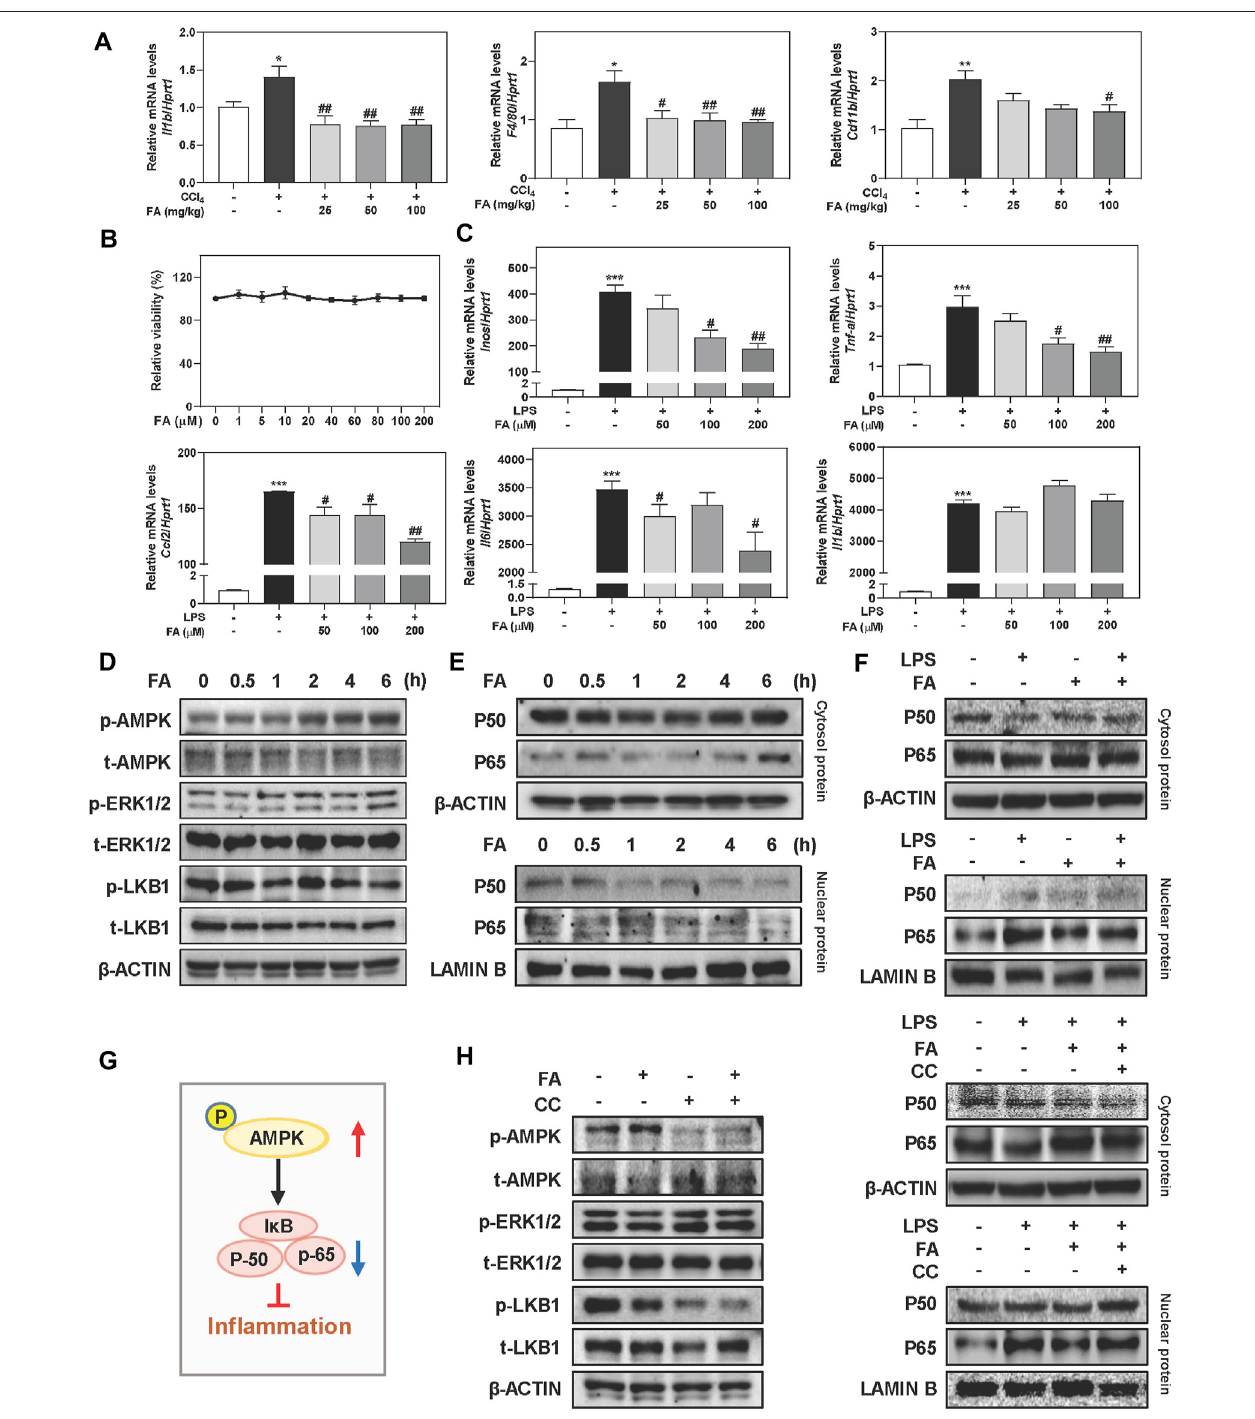
FIGURE 3 | FA suppresses LPS-induced macrophage activation in RAW cells. (A) Relative hepatic mRNA levels of Il1b, F4/80 and Cd11b were determined by qPCR and normalized using Hprt1 as an internal control in mice. (B) A CCK-8 assay. (C) RAW cells were pre-treated with FA at different concentrations for 1 h and then treatedwithLPS(100 ng/ml)foranother4 h. (D,E) RAWcellsweretreatedwith100 μ MFAatdifferenttimepoints. (F,H) AftertreatedwithCC(10 μ M)orFA(100 μ M)or both, RAW cells were administrated with LPS for another 4 h. (G) The pathway of AMPK and NF- κ B involved in in fl ammation. (D-F and H) Representative immunoblots against p-AMPK, t-AMPK, p-ERK1/2,t-ERK1/2, p-LKB1, t-LKB1, P50, P65, β -ACTIN and LAMIN B wereshown. Statistical signi fi cance: * p < 0.05, *** p < 0.01, *** p < 0.001, compared with control group; # p < 0.05, ## p < 0.01, compared with LPS group. One-way ANOVA with Tukey ’ s post-hoc tests ( n (cid:1) 3).